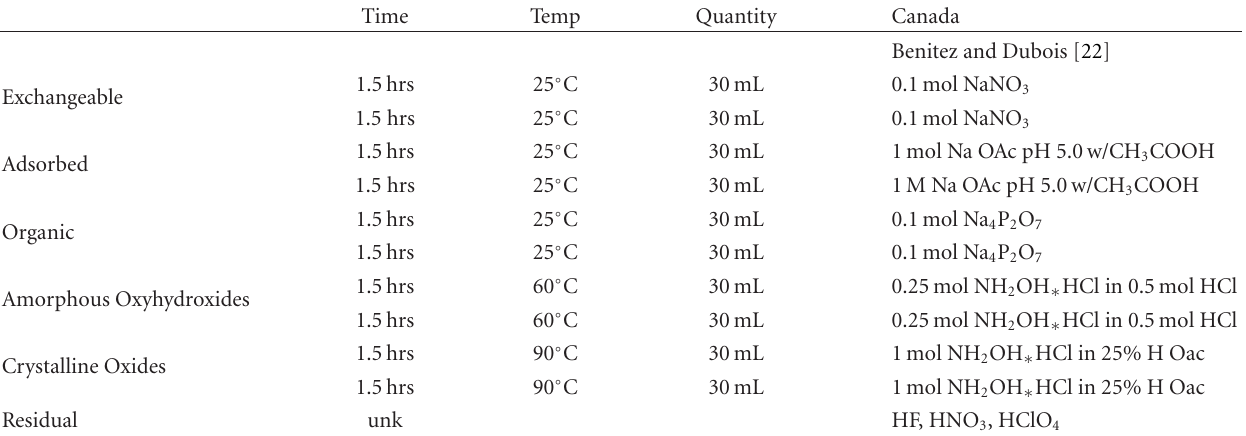
Table 2: Operating conditions for the modified GCS extraction procedures using 1g of